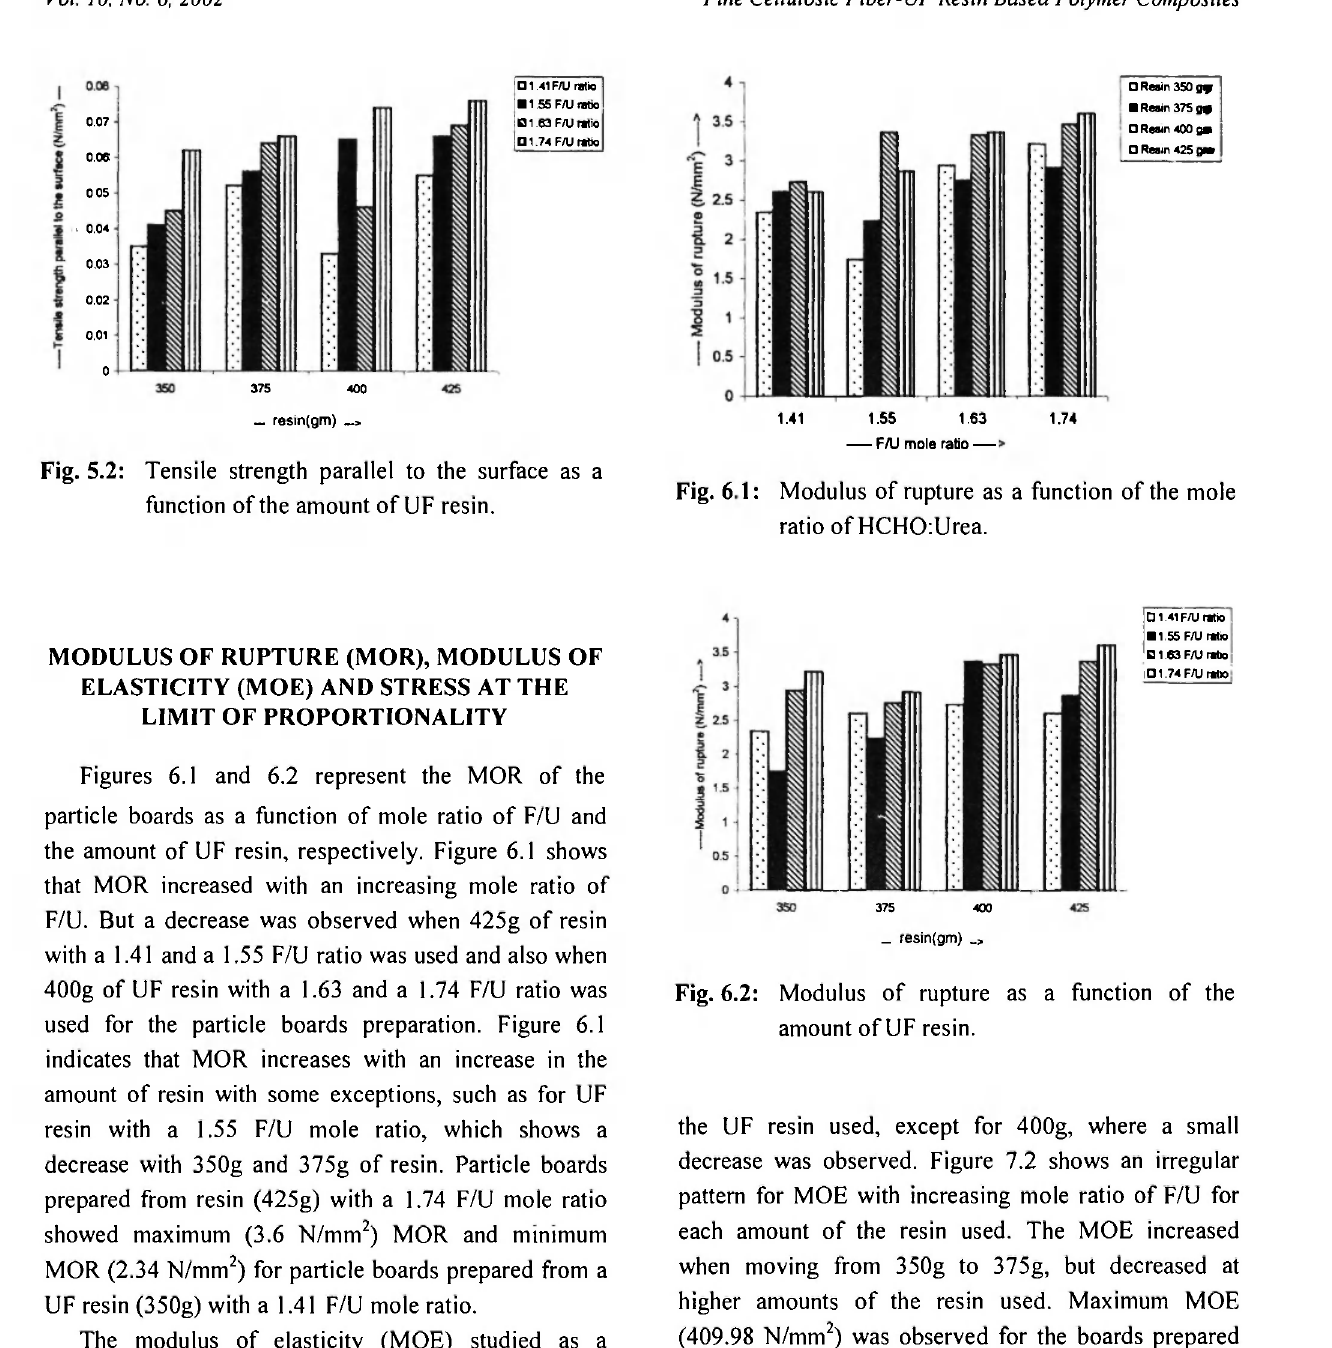
Fig. 5.2: Tensile strength parallel to the surface as a function of the amount of UF resin.